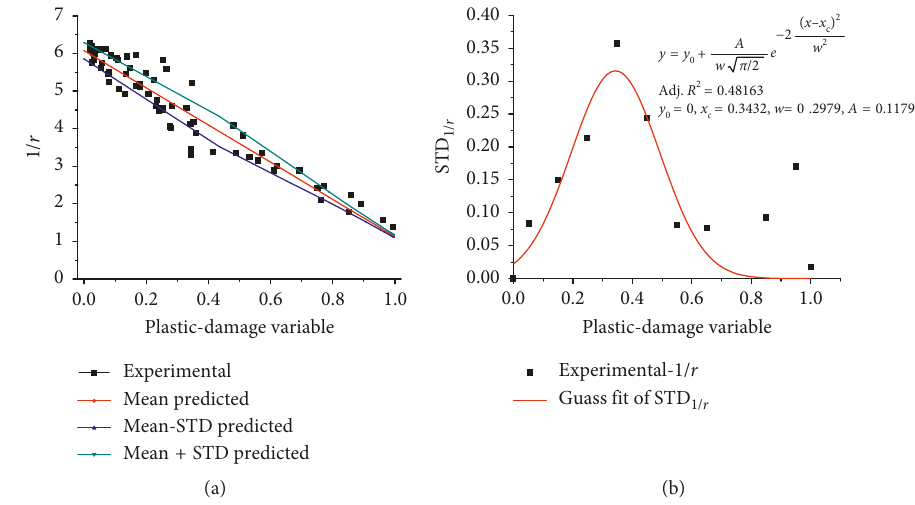
Figure 6: Comparison of experimental and predicted stochastic plasticity of SCC under uniaxial cyclic compression. (a) Experimental and predicted 1/ r vs. dr . (b) Experimental and predicted STD .